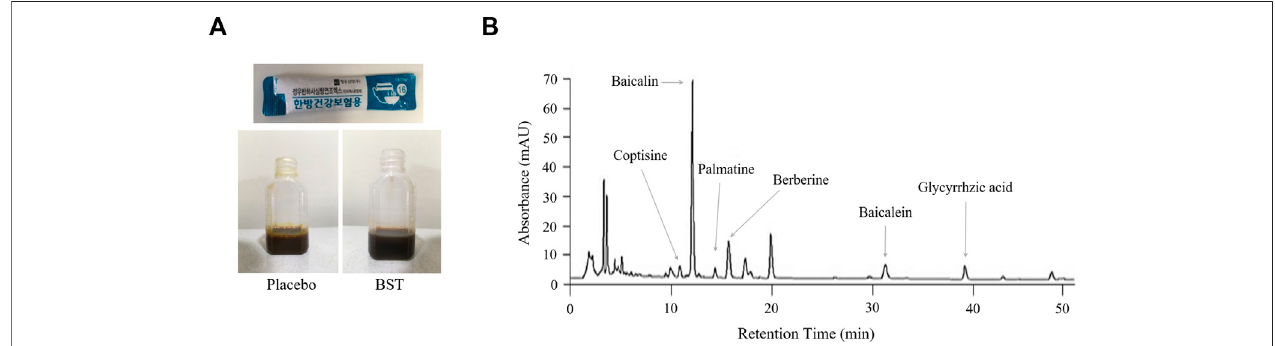
FIGURE2| Fingerprintanalysis.TherealimagesofplaceboandBSTsyrup (A) and Banha-sasim-tang (BST)usingultra-high-performanceliquidchromatography- tandem mass spectrometry (UHPLC-MS/MS) (B) .